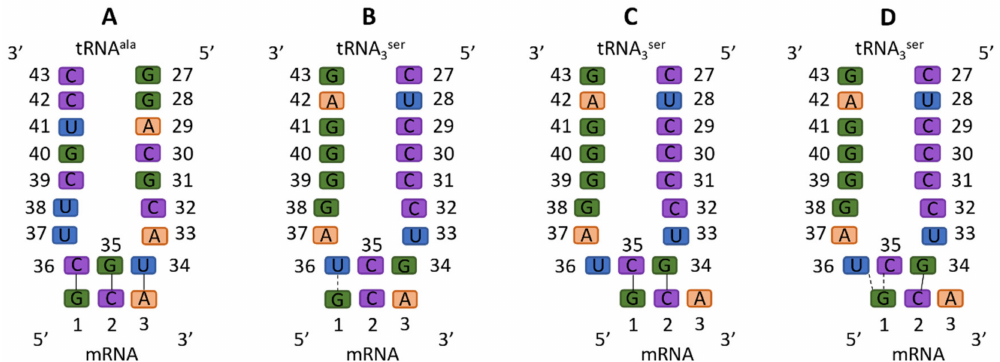
Figure 1. Standard and non-standard codon–anticodon interactions in the A site. Solid connectors indicate a Watson–Crick (WC) base pair, whereas dashed connectors indicate a non-standard interaction. ( A ) Standard cognate binding, in which all three WC base pairs are formed. ( B ) Binding of the frameshift-inducing tRNA in a standard way, where only one wobble base pair can be formed. ( C ) Doublet decoding model: The frameshift-inducing tRNAs bind to the frameshifting sites with two WC base pairs formed. Notably, as tRNA base 36 is not involved, under that model the U36C mutation should have no e ff ect on tRNA Ser3 frameshifting. ( D ) Straddling interactions of mRNA G1 with tRNA U36 and C35, as observed in our simulations and described in the